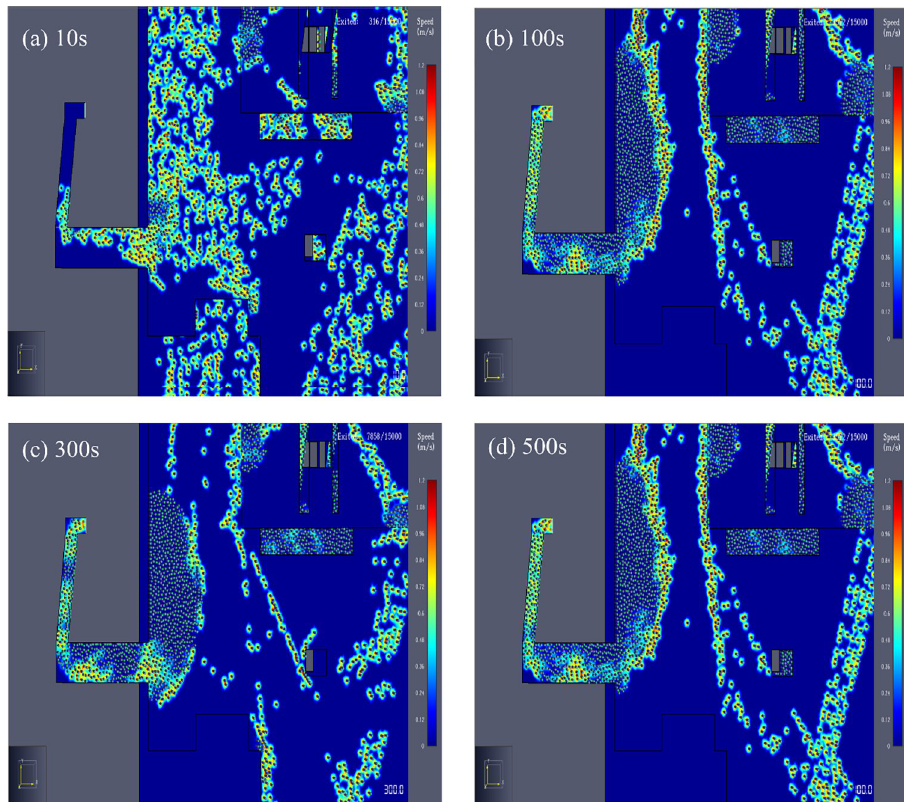
Fig 6. Flow rate and speed distribution of evacuees near Exit B at different moments. (a) 10s, (b) 100s, (c) 300s, and (d) 500s.